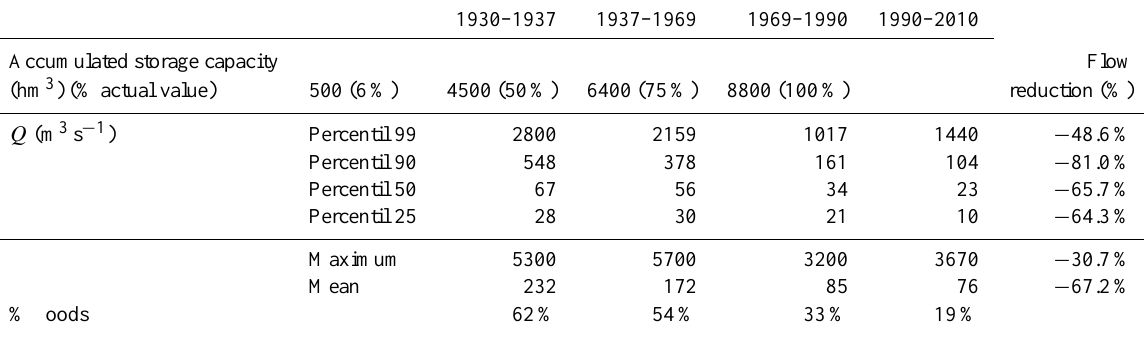
Table 2. Storage capacity of the contributing area to the estuary of Guadalquivir accumulated at the end of each period. Mean daily flow distribution in Alcalá del Río reservoir for selected percentiles during the four periods associated with increasing regulation levels in the upstream basin. In the last column, flow reduction values with respect to the initial period value.